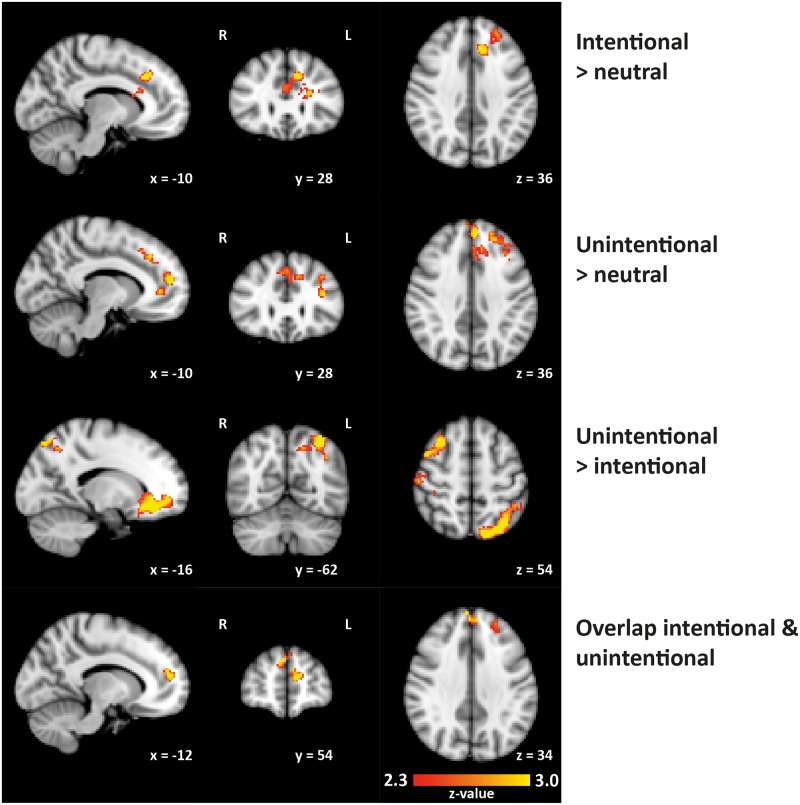
Significant activation clusters related to processing stories describing social norm violations.Clusters are superimposed on the template MNI_T1_152_2mm_brain (partial brain coverage; inferior parts of the frontal medial cortex and superior parts of the postcentral gyrus are not included). All images are displayed according to radiological convention: right in image is left in brain.